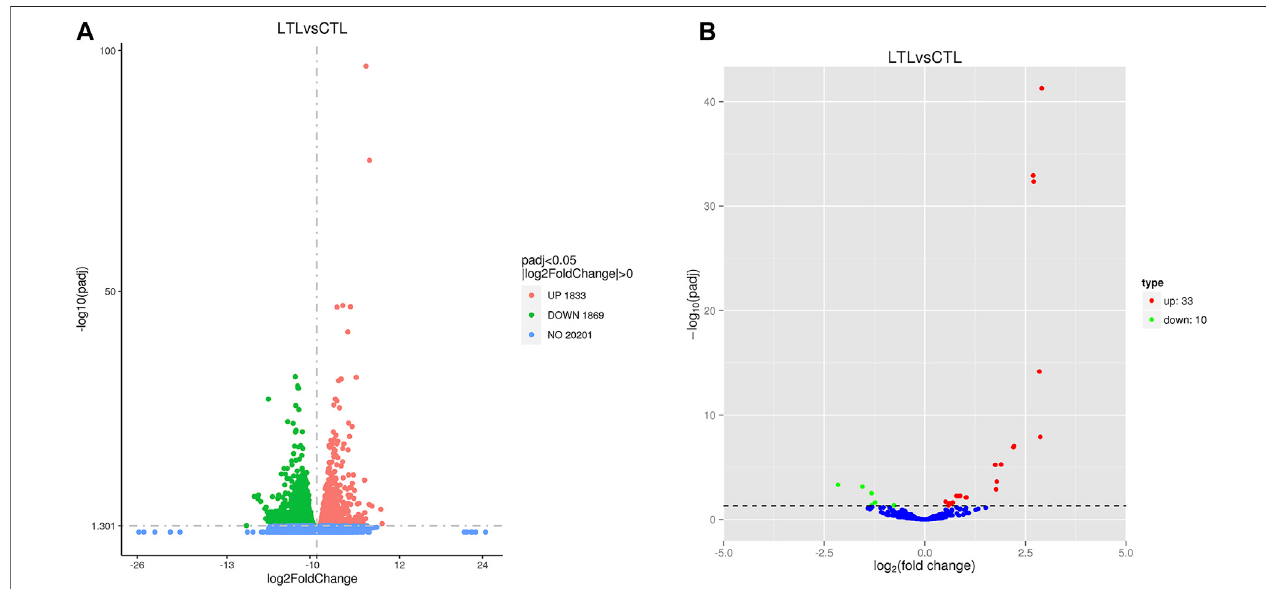
FIGURE1| Volcano plotsshowing differentially expressed genes (A) and miRNAs (B) identi fi edbetweenthetwotreatmentgroups. Redand greencircles indicate signi fi cantly upregulated and downregulated differences, respectively ( p < 0.05), while blue circles indicate no differences.